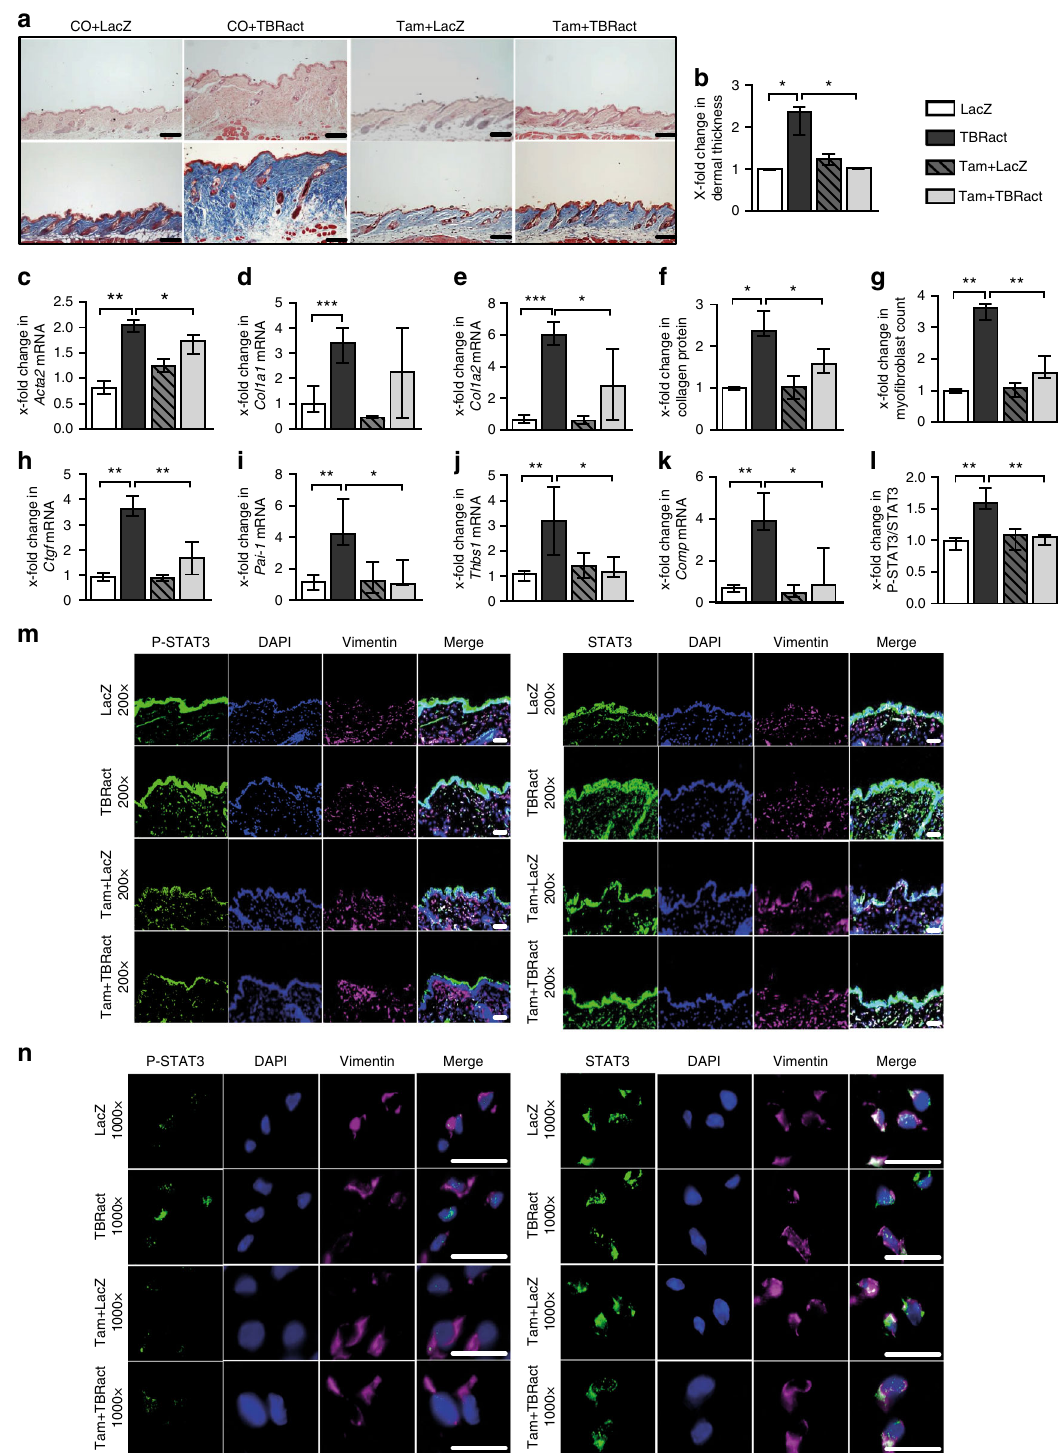
Fig. 7 Fibroblast-speci fi c knockout of STAT3 reduced the effects of TBRact-induced skin fi brosis. a Representative histological sections stained with hematoxylin and eosin (top) and trichrome (bottom). b Dermal thickness, c – e mRNA levels of Acta2 , Col1a1 , and Col1a2 , respectively, f hydroxyproline content, g myo fi broblast count, and h – k levels of h Ctgf mRNA, i Pai-1 mRNA and of the proposed biomarkers, j Thbs1 mRNA and k Comp mRNA. m , n Representative immmuno fl uorescence stainings of P-STAT3 (left) and total STAT3 (right) at 200-fold and 1000-fold magni fi cation, respectively, along with their l quantitative analyses. All experiments were performed in dermal tissue sections from the experimental mouse model of TBRact-induced skin fi brosis in mice with fi broblast-speci fi c, tamoxifen-inducible, Cre-loxP-based ( Col1a2-Cre-ER ) knockout of STAT3 in STAT3 fl / fl mice and control littermates (C57Bl/6background, 12 weeks of age). N ≥ 6 with 2 technical replicates per group for all experiments. Results are shown as median ± interquartile range (IQR). Horizontal scale bar, 100 μ m. Signi fi cance was determined by Mann – Whitney test, as compared to vehicle-treated, fi brotic mice, respectively. * P < 0.05; ** P < 0.01***; P < 0.001. Tam tamoxifen; CO,